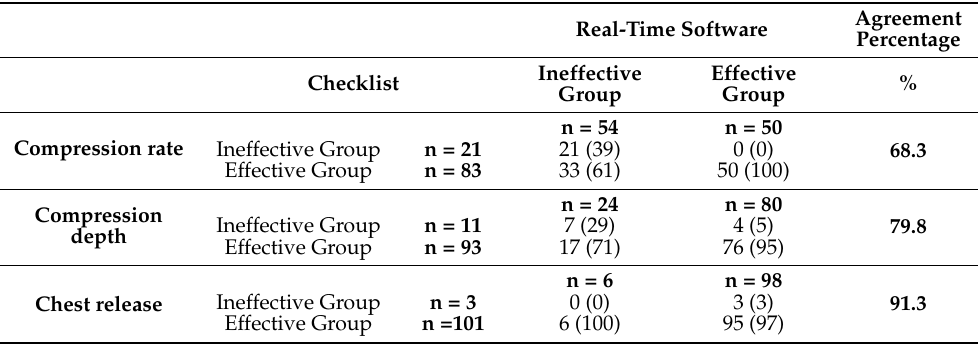
Table 2. Analysis of agreement percentage for each compression skill between a checklist and a real-time software in the Effective vs. Ineffective groups of